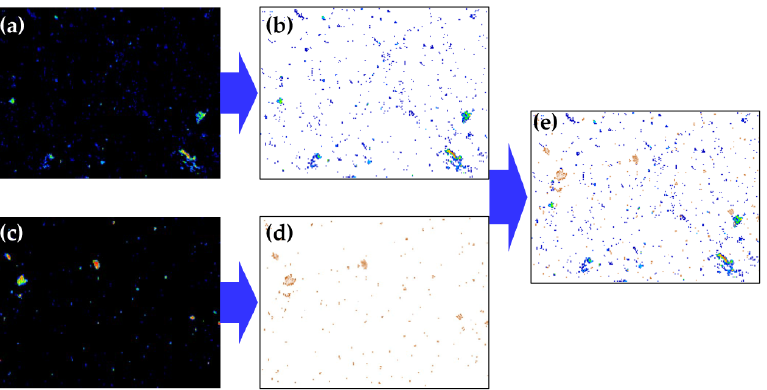
Figure 9. The elemental mapping of ( a ) C and ( c ) Te of Bi 0.5 Sb 1.5 Te 3 /CNTs cement composites at 1.0 vol.% Bi 0.5 Sb 1.5 Te 3 . The corresponding elemental distributions, which were extracted from ( a , c ), are shown in ( b , d ). The elemental distribution of ( d ) Te is overlayed on the elemental distribution of ( b ) C to explore the conductive network with ( e ) C+Te.